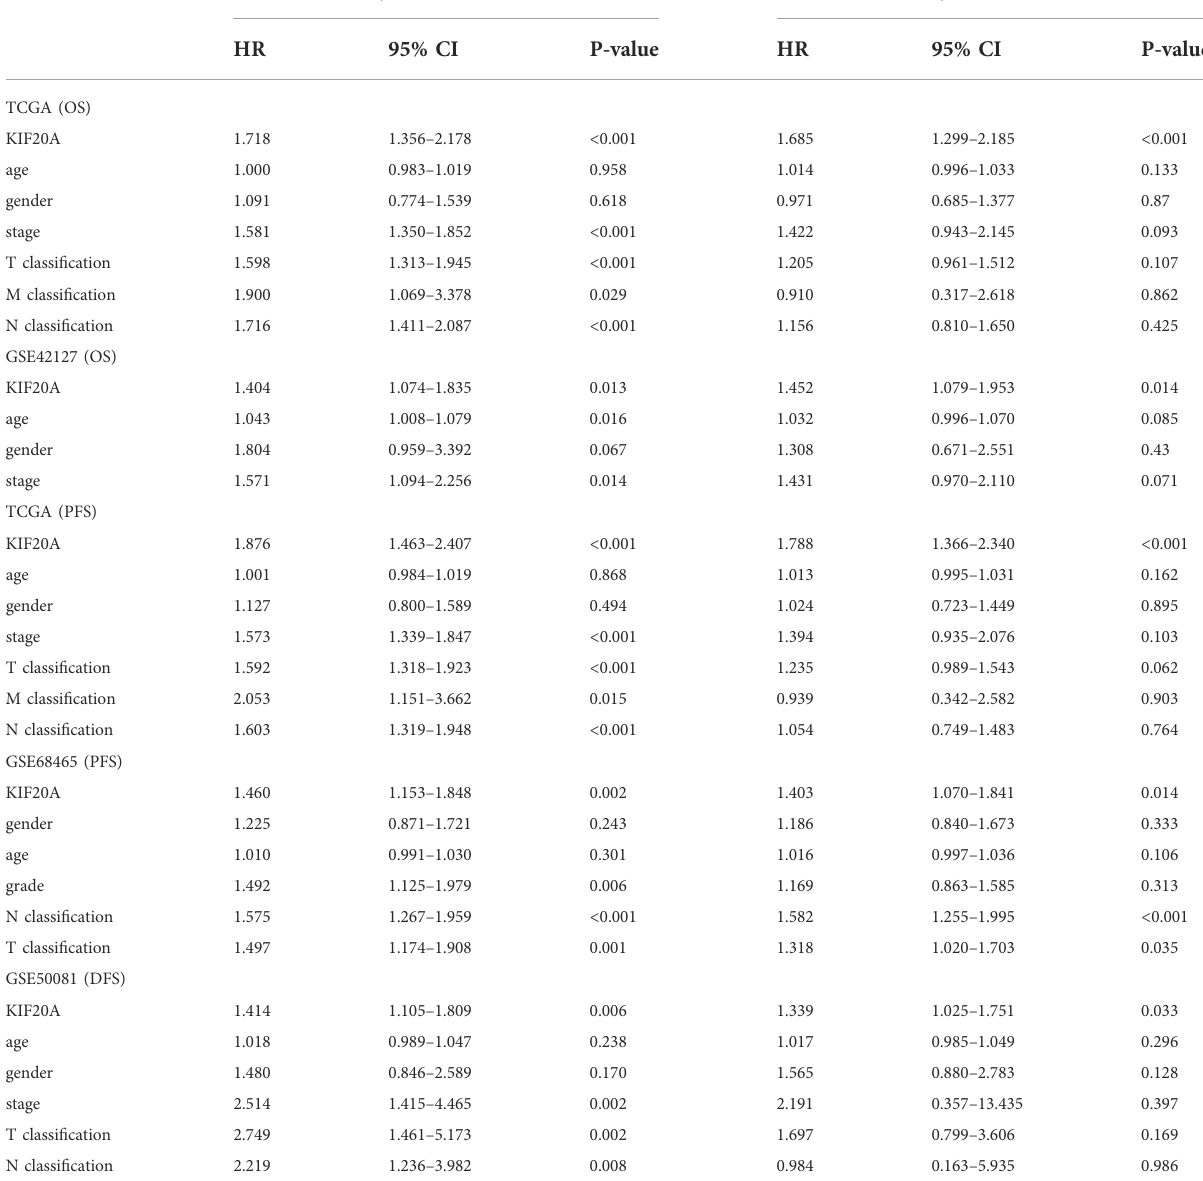
TABLE 2 Univariate Cox regression analysis for KIF20A expression on OS, PFS, and DFS in LUAD